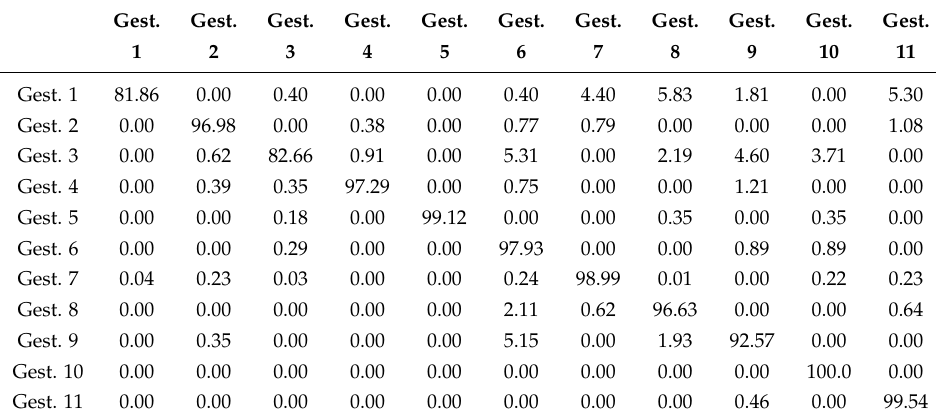
Table 6. The confusion matrix of the Residual PairNet over the testing dataset. The cell located at row i and column j of the matrix represents the percentage in which the gesture in the row i is classified as the gesture in the column j . Gest. Gest. Gest. Gest. Gest. Gest. Gest.